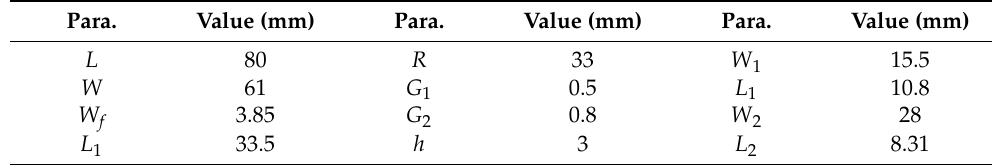
Table 3. Parameter dimensions of the MBRU antenna.